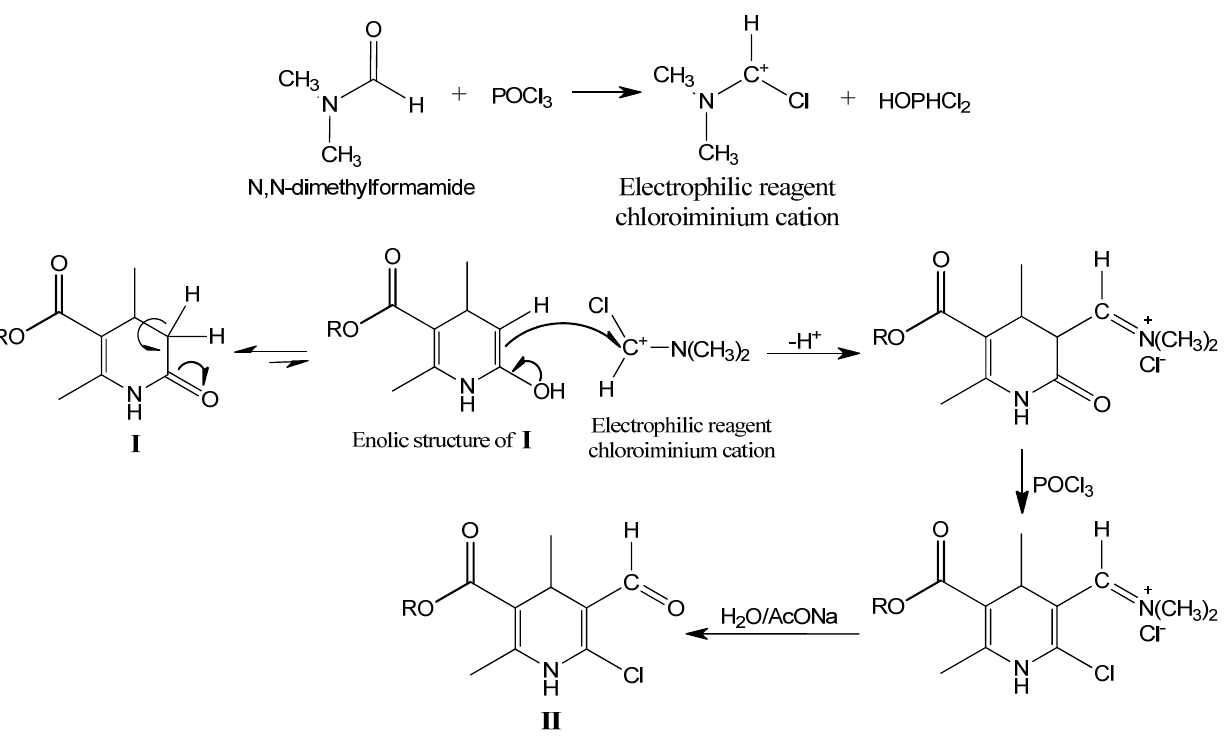
Scheme 2. The proposed mechanism of the chloroformylation